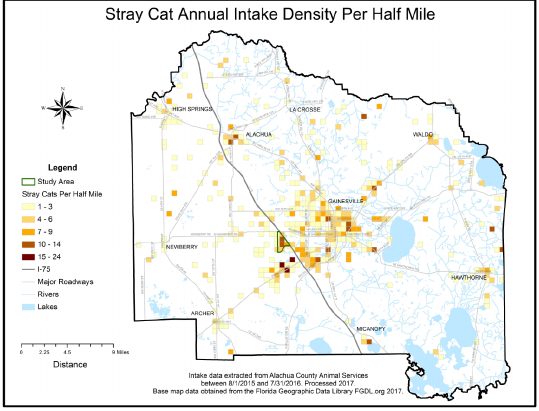
Figure 4. Stray Cat Annual Intake Density Map.